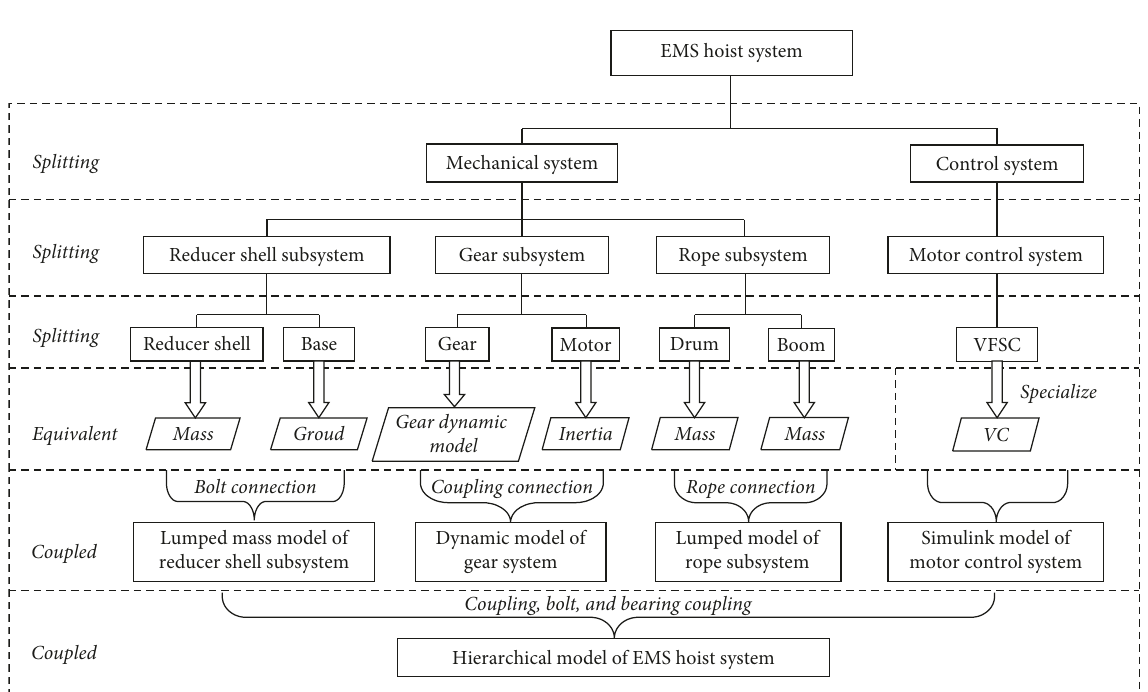
Figure 2: Hierarchical modeling flow of the EMS hoist